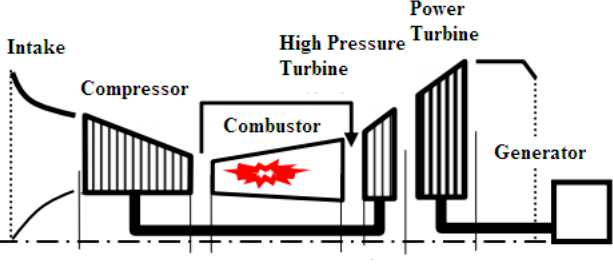
Figure 1. Gas turbine configuration of this case study.